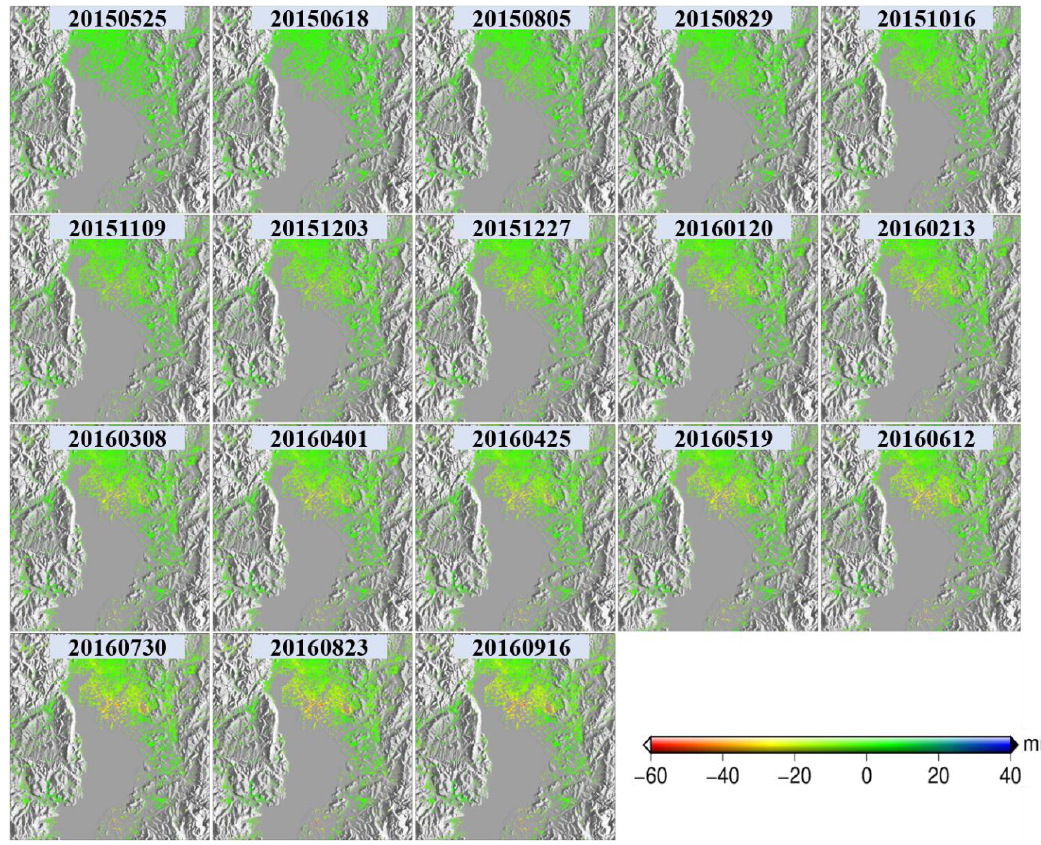
Figure A4. Time series deformation in Kunming observed using C-band Sentinel-1A images with descending orbit between 25 May 2015 and 16 September 2016.